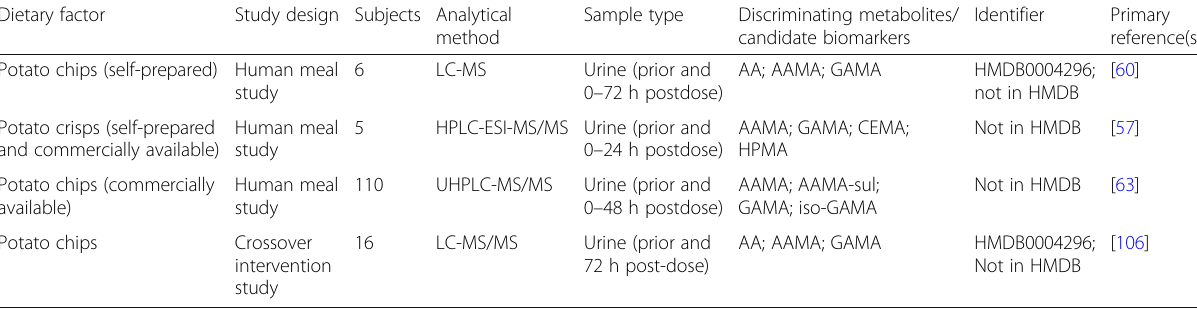
Table 3 List of reported putative biomarkers for potato chips and fries intake Dietary factor